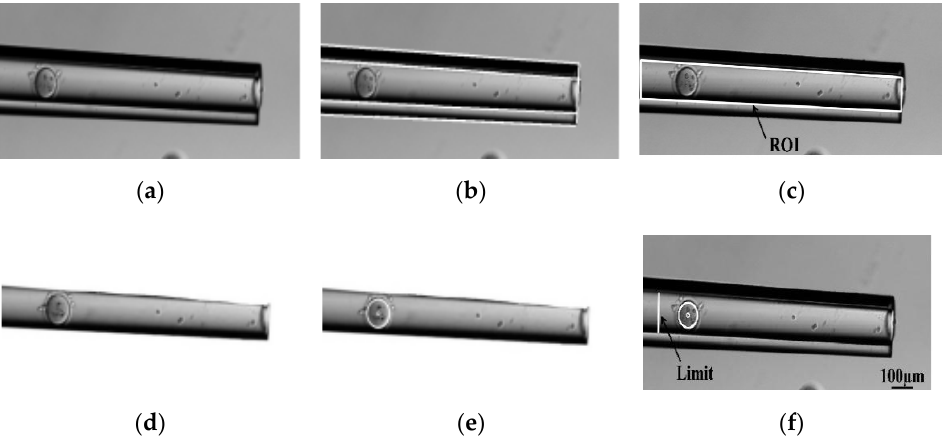
Figure 7. Image sequence of oocyte recognition inside the micropipette. ( a ) Smoothed image; ( b ) Hough transform line detection; ( c ) ROI containing the inside of the micropipette; ( d ) Extracted ROI image; ( e ) Oocyte recognition in ( d ); ( f ) Oocyte recognition within limit.